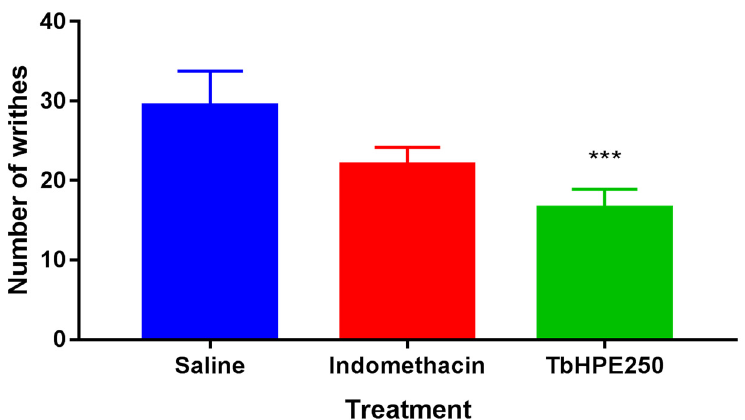
Figure 4. Effects of oral treatment with hydroethanolic pollen extract collected by Scaptotrigona affinis postica (TbHPE) on control of writhing induced by administration of 0.8% acetic acid. Mice treated with saline, indomethacin (10 mg/kg), TbHPE 250 mg/kg. *** p < 0.001 vs. saline; (ANOVA; Tukey).